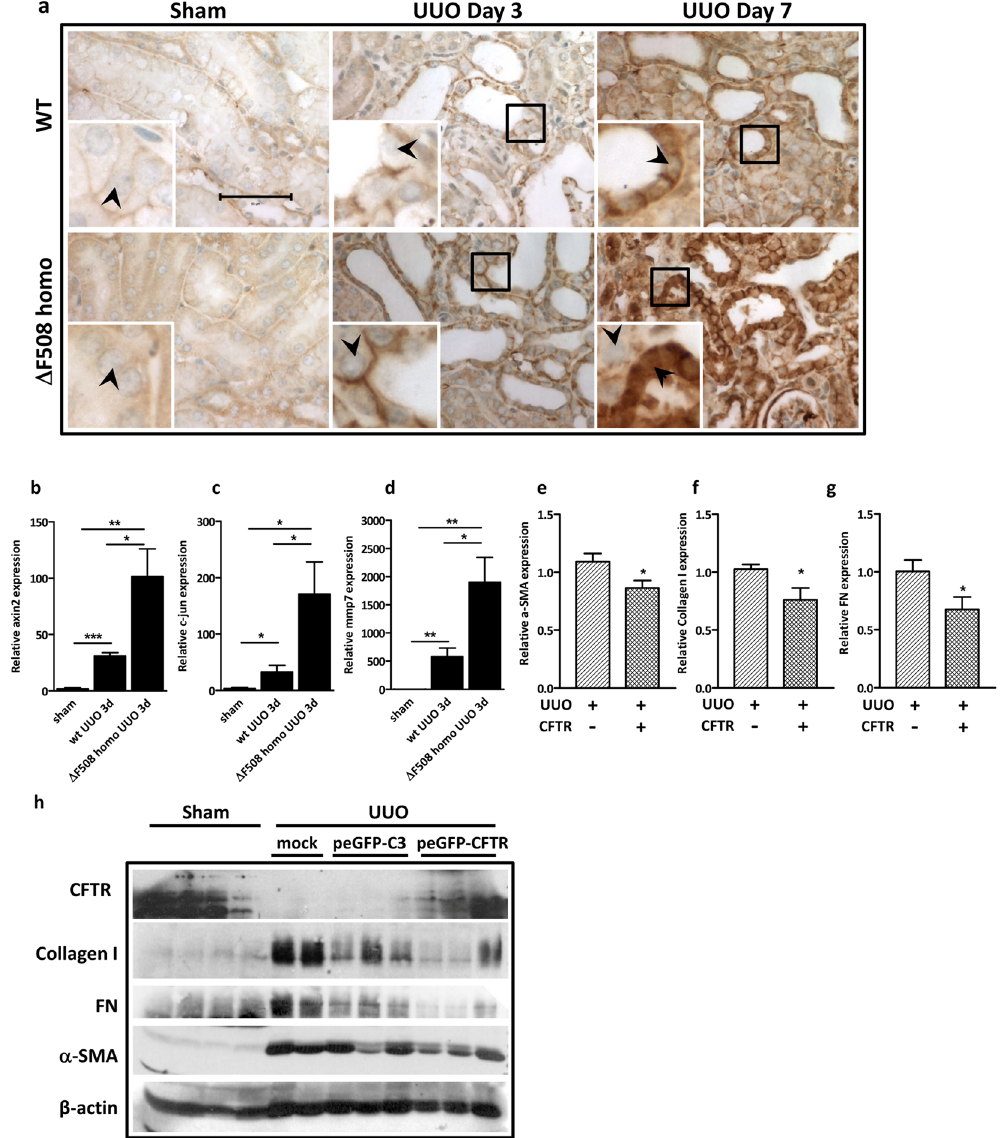
Figure 6. Overexpression of CFTR alleviates fibrotic phenotype in UUO model. ( a ) Immunohistochemical staining showing the dramatically increased expression of β -catenin in delta F508 mice compared to wild type mice after UUO. The black box marks the area enlarged, and the black arrows indicate the nuclear localization of β -catenin, scale bar = 50 µ m; ( b–d ) Real time-PCR analysis showing higher expression levels of Axin-2, c-jun and Mmp7 in the delta F508 mice than that in the wild type mice after UUO. * p < 0.05, ** p < 0.01, *** p < 0.001, n = 3; ( e–h ) CFTR overexpression abrogates kidney fibrosis in mice. ( e–g ) Real time-PCR analysis showing the decreased expression of α -SMA, collagen I and FN in peGFP-CFTR overexpression kidneys. * p < 0.05, quantification analysis represents data from 9 control and 10 CFTR overexpressed UUO kidneys. ( h ) Representative western blot showing the decreased expression of matrix protein and α -SMA in CFTR overexpressed UUO kidneys (peGFP-CFTR) comparing to control UUO kidneys (peGFP-C3) and mock UUO kidney (injected same volume of microbubbles without any DNA). (Full-length blot is shown in Supplementary Figure